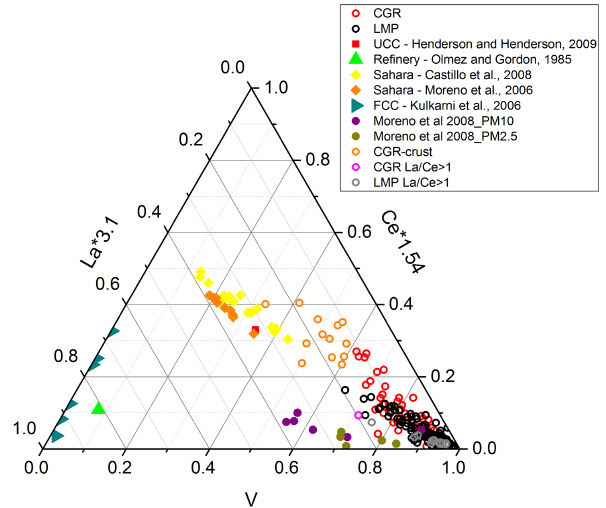
Figure 5. Three-component Ce-La-V plot for LMP and CGR. Lit- erature data for different aerosol types are also